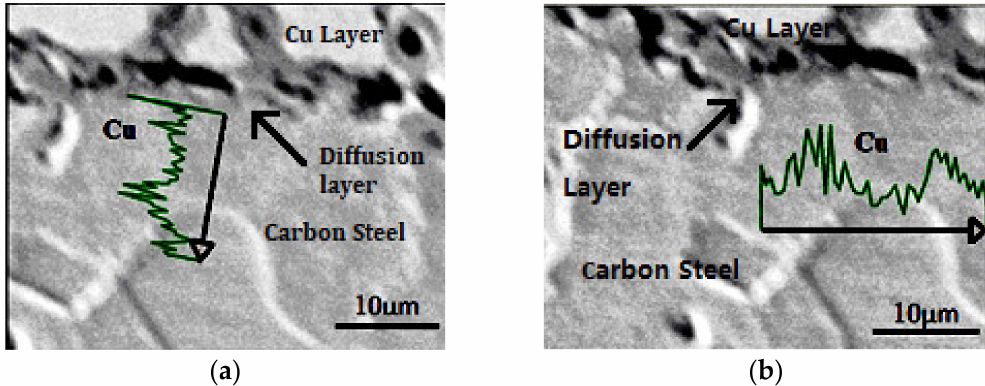
Figure 3. SEM image and EDS line scanning of grain boundary of Cu − Fe ( a ) Longitudinal analysis and ( b ) Lateral analysis.